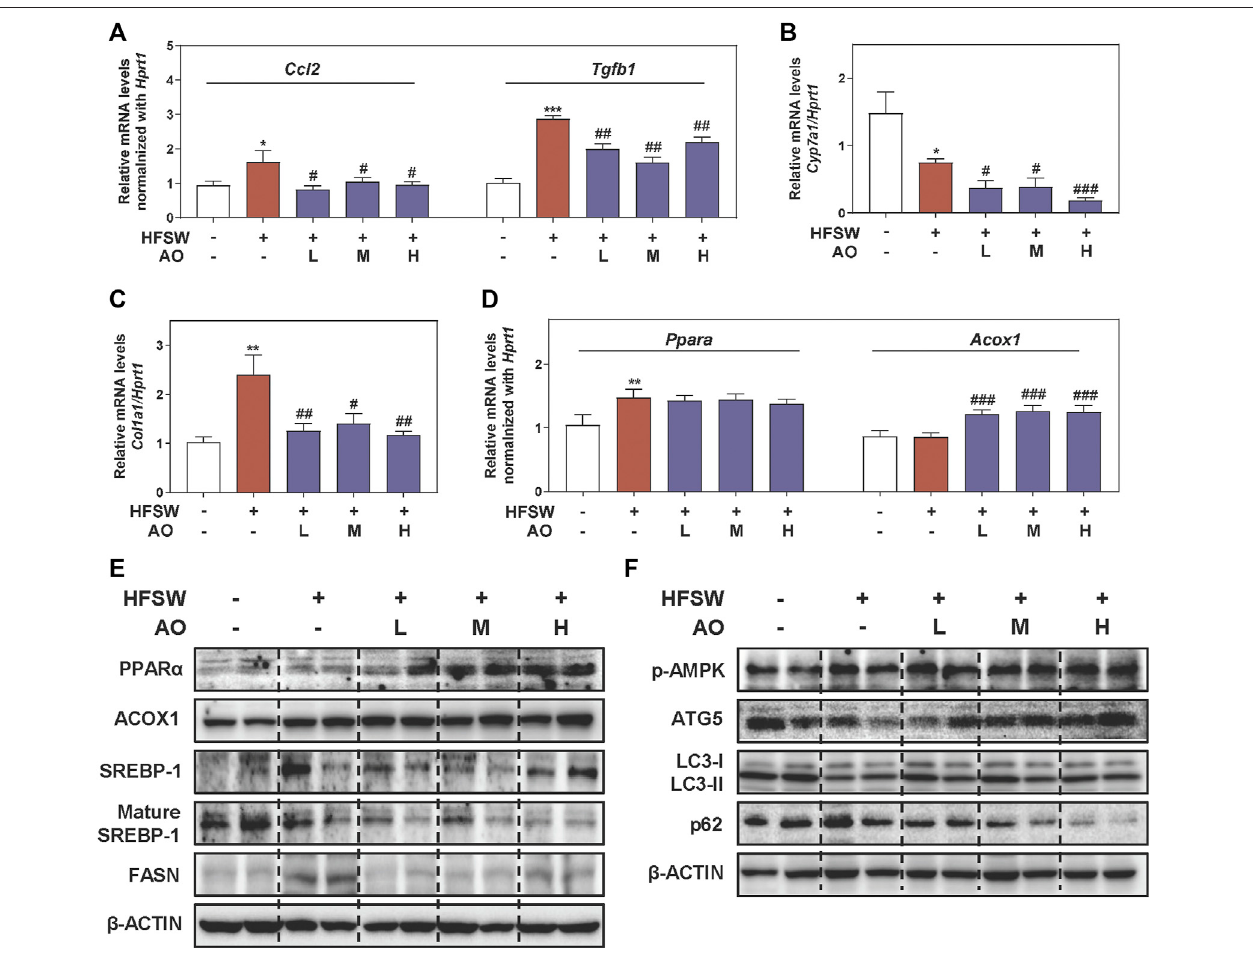
FIGURE2| AOimproveslipidmetabolismandactivatesautophagypathwayinHFSW-fedmice.Miceweretreatedwiththesamemethodasdescribedin Figure1 . Relative mRNA levels of (A) Ccl2 and Tgfb1 , (B) Cyp7a1 , (C) Col1a1 and (D) Ppara and Acox1 in liver tissues were determined by qPCR and normalized using Hprt1 as an internal control. The protein levels of (E) PPAR α , ACOX1, SREBP-1, mature SREBP-1, FASN, (F) p-AMPK, ATG5, LC3-II/LC3-I and p62 in the liver were determined bywesternblotusing β -ACTINasaloadingcontrol.Statisticalsigni fi cance:* p < 0.05,** p < 0.01,*** p < 0.001,compared withcontrolgroup; # p < 0.05, ## p < 0.01, ### p < 0.001, compared with HFSW group (n (cid:1)